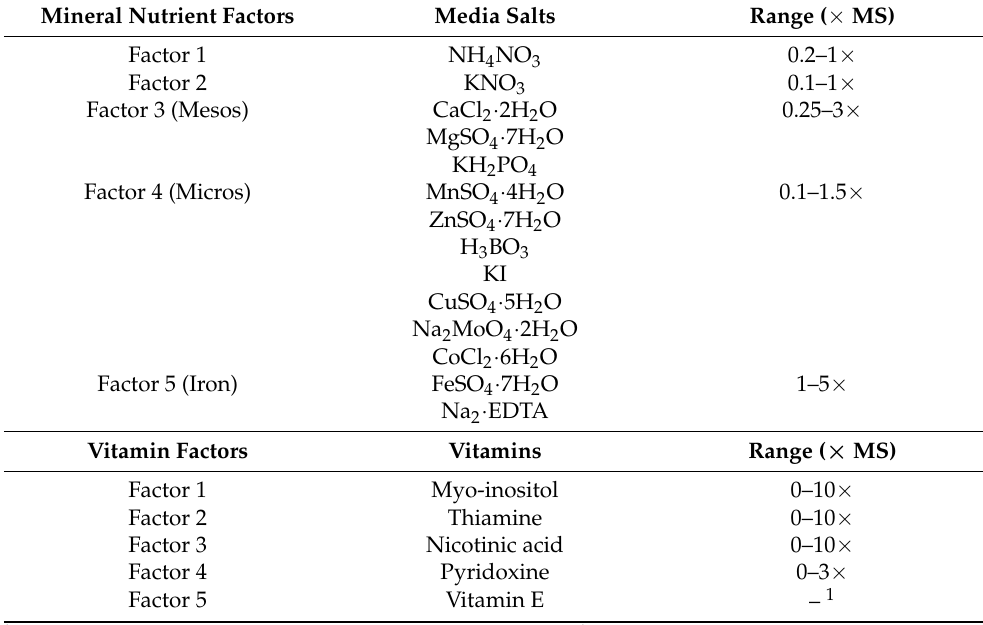
Table 5. Design Expert ® ’s five-factor design for the mineral nutrient and vitamin